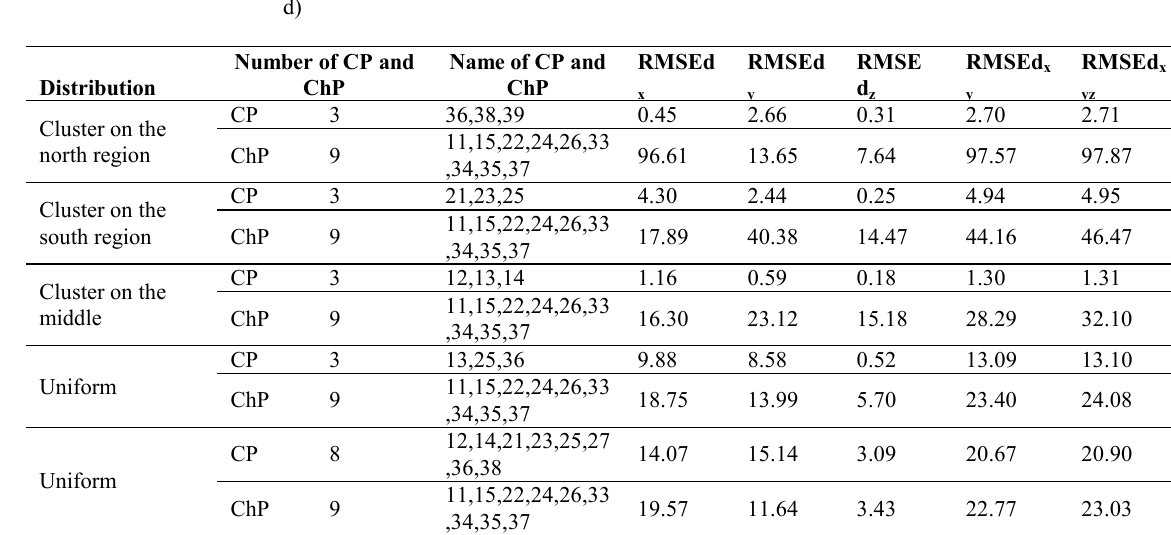
Table 3. According to different combination, RMSE of residuals on CPs and ChPs [units: